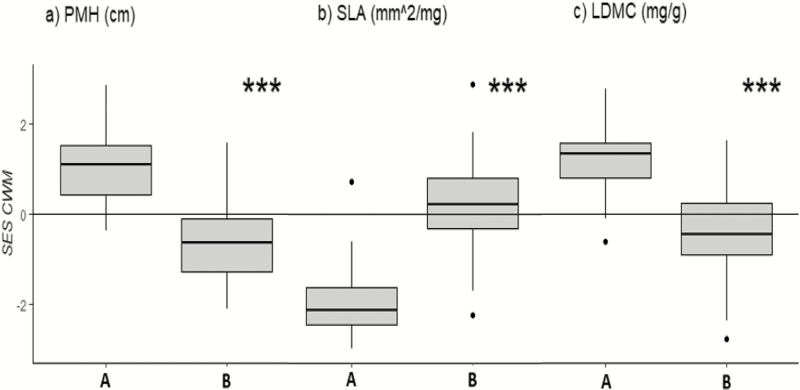
Box plots comparing the standardized effect size (SES) CWMt values of subalpine Sesleria juncifolia (A on the horizontal axis) and alpine Silene acaulis (B on the horizontal axis) communities. The differences in the CWMt are significant for (A) plant maximum height (PMH), log cm; (B) specific leaf area (SLA), log mm2 mg−1; and (C) leaf dry matter content (LDMC), log mg g−1. Statistical significance according to the Mann–Whitney U-test is represented by asterisks (non significant P > 0.05; *P < 0.05; **P < 0.01; ***P < 0.001).